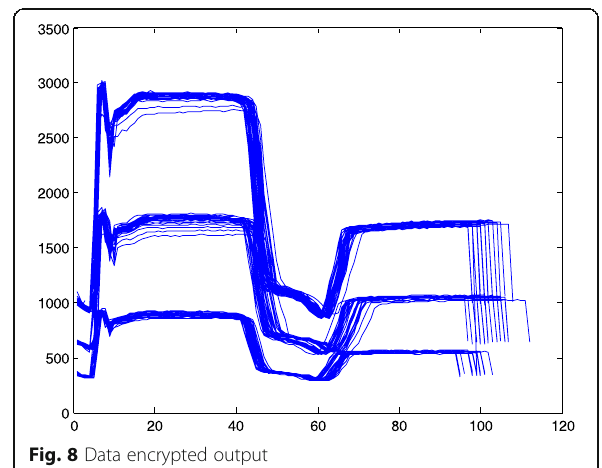
Fig. 9 that the encryption performance of data protec- tion in social network is better by using this method.